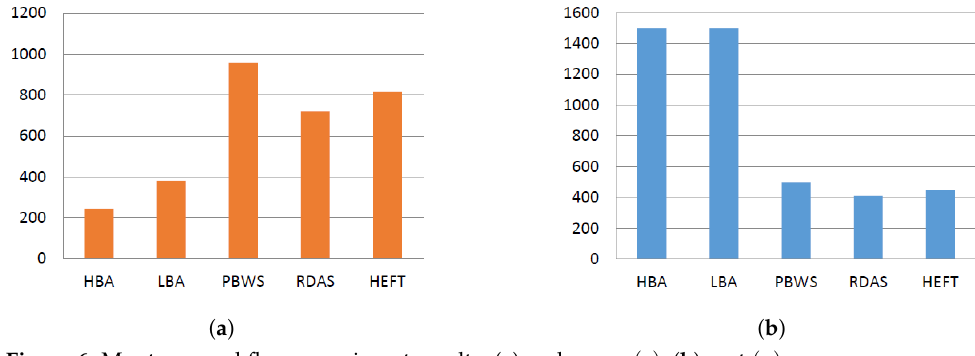
Figure 6. Montage workflow experiment results. ( a ) makespan ( s ) ; ( b ) cost (  ) .